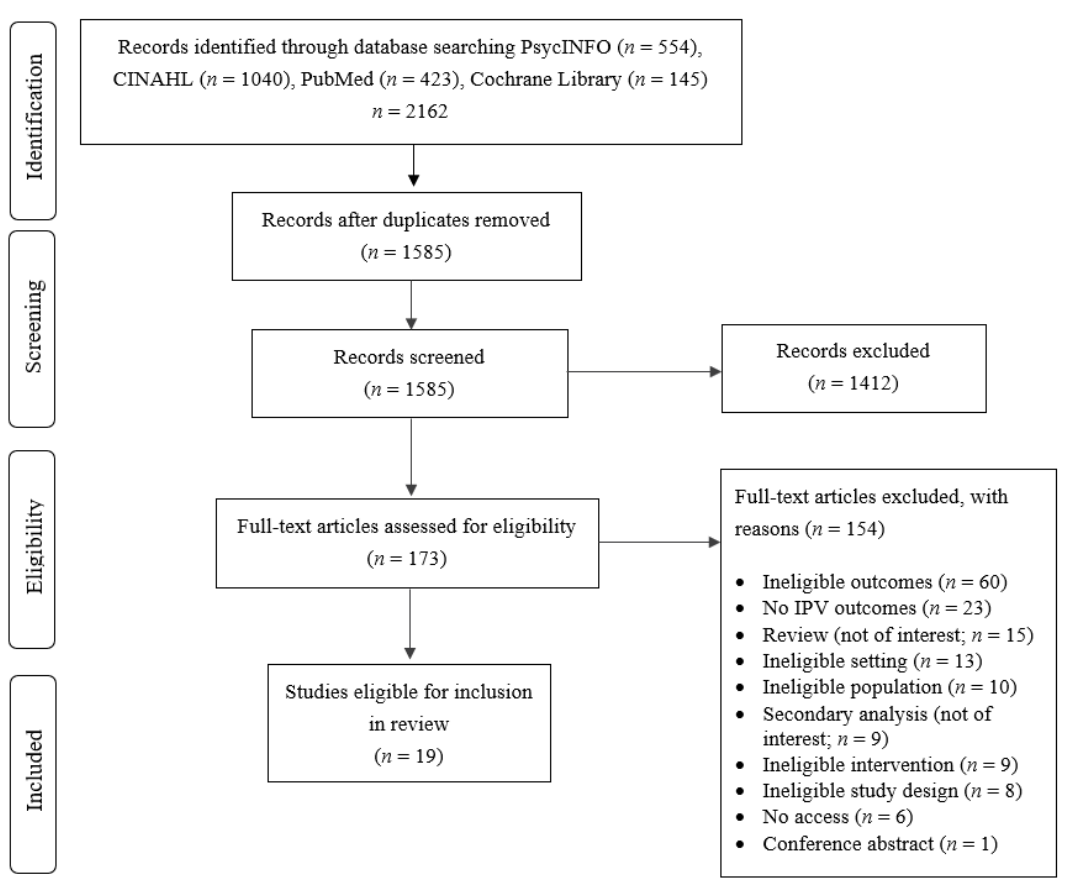
Figure 1. Schemes follow the same formatting. Figure 1. PRISMA flow